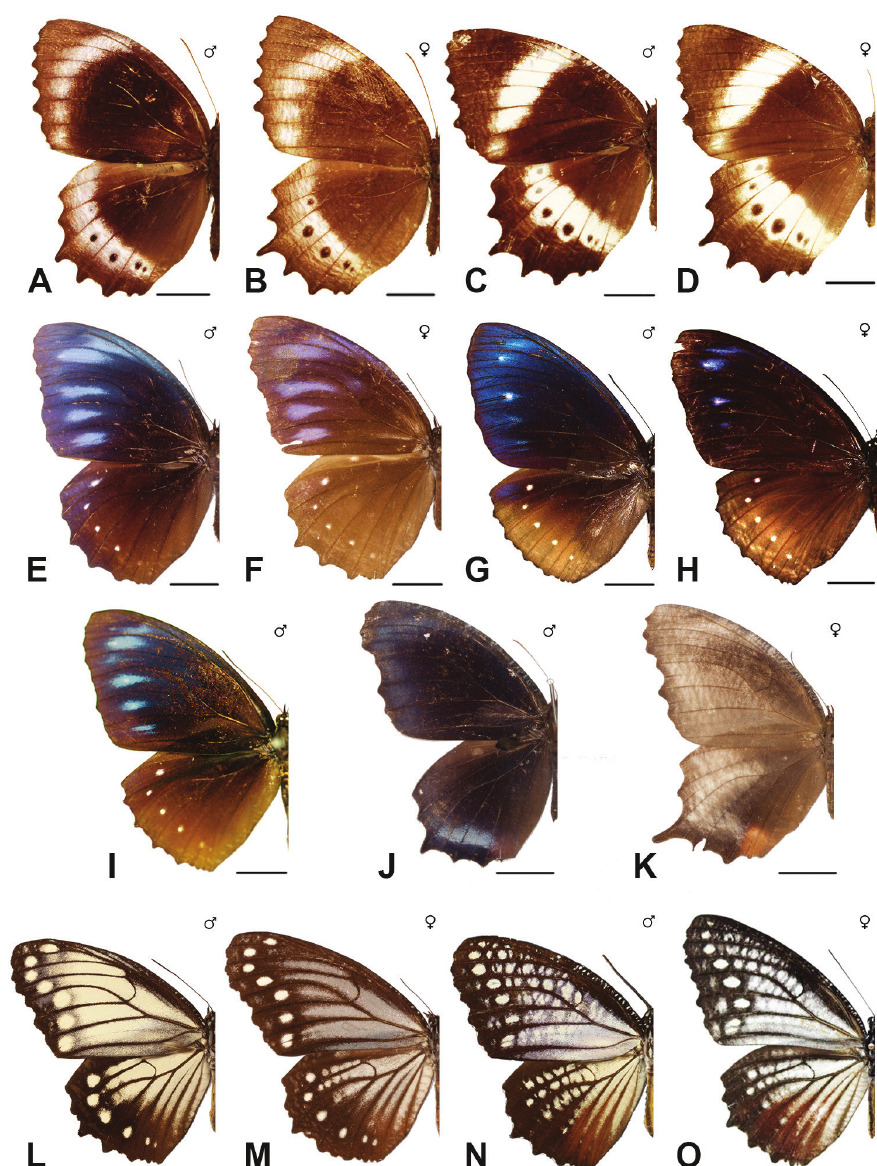
Figure 3. A dara bengena ♂ D NHM Indonesia: West Java B dara bengena ♀ D NHM Indonesia: West Java C dara daedalion ♂ D NHM Myanmar D dara daedalion ♀ D NHM Myanmar E patna patna ♂